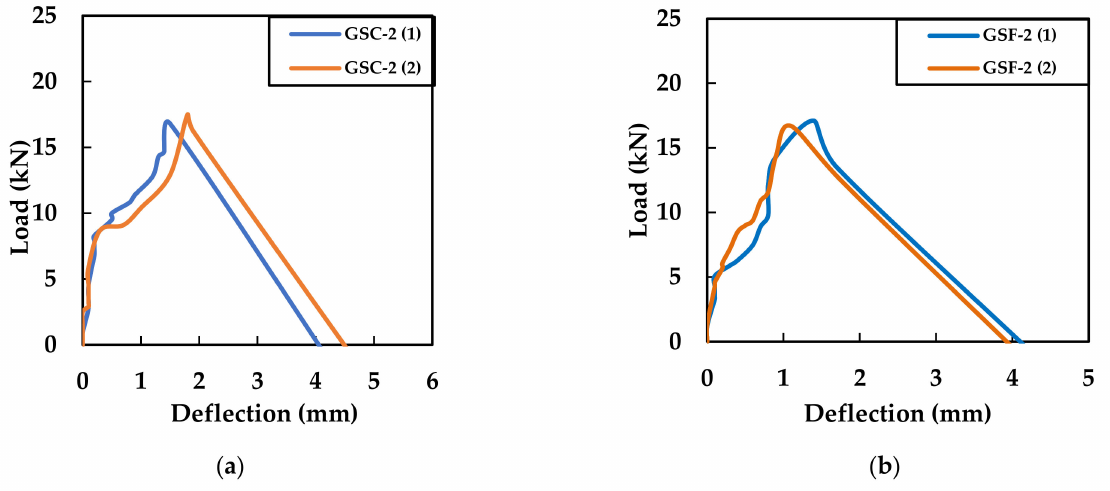
Figure 8. Load–deflection behaviour of ( a ) GSC-2 and ( b ) GSF-2.